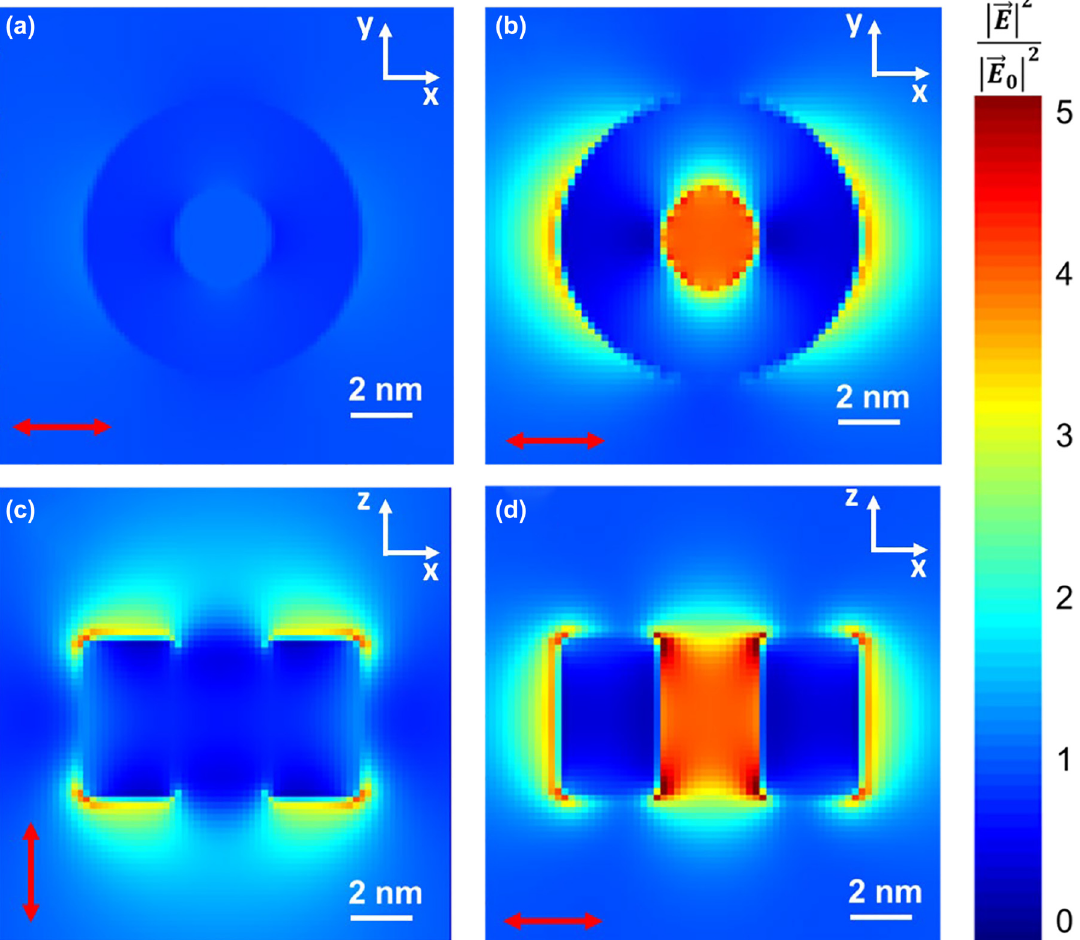
Figure 6: Two dimensional electric field intensity distributions at 609 nm for the 3D models of the bio-inspired nanostructures based on the LH2 of Rhodospirillum molischianum bacteria. Electric field intensity distribution in the XY plane crossing the nanoring in the middle for linear polarised light travelling in Z direction and polarised along X direction for (a) PVA-only nanoring and (b) J619 J-aggregate:PVA nanoring (oscillation direction indicated by the red arrows). Electric field intensity distribution at 609 nm in the XZ plane crossing in the middle a J619 J-aggregate:PVA nanoring for light linearly traveling in Y direction and polarised along the Z direction (c, see Figure 5(c)) and X direction (d, see Figure